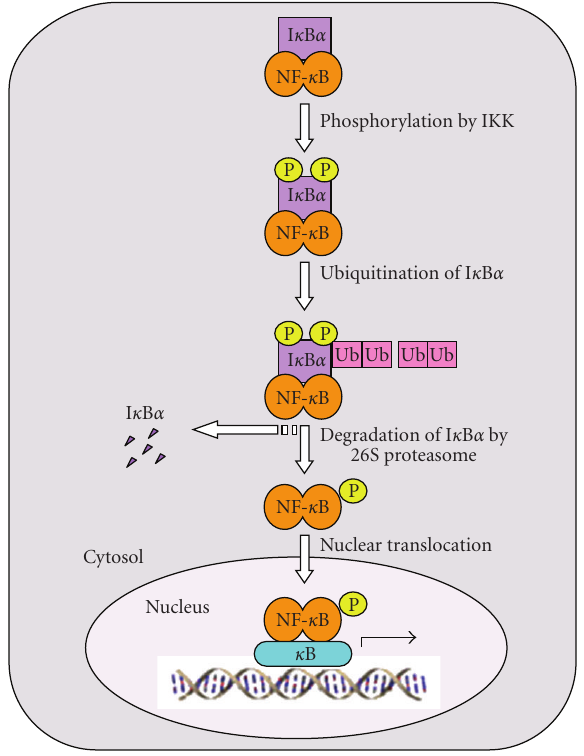
Figure 3: Regulation of I κ B α and I κ B β . A cartoon representing the most critical intracellular events leading to NF- κ B transcriptional activation. Interaction between diverse ligands and their receptors eventually leads to activation of the IKK complex, which allows I κ B α and I κ B β phosphorylation in the cytosol. This phosphorylation step is followed by I κ B α , but not I κ B β , ubiquitination, and subsequently, I κ B α and I κ B β are subjected to proteolytic degradation. Once I κ B α and I κ B β molecules are degraded, NF- κ B dimers are liberated, and they translocate to the nucleus subsequent to unmasking of their NLS. Once in the nucleus, NF- κ B dimers bind to κ B sites within the promoter/enhancer regions of their target genes, driving gene